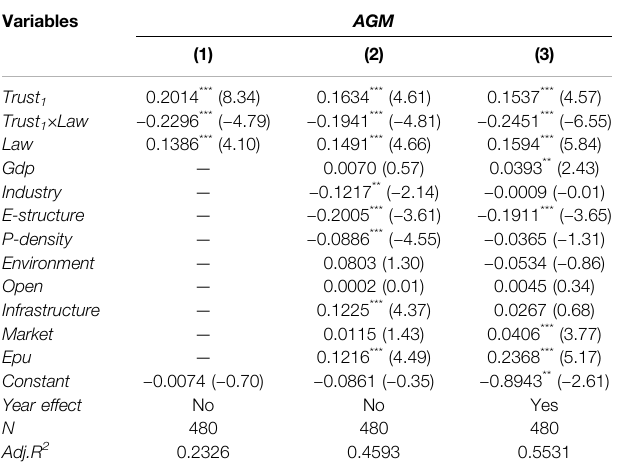
TABLE 5 | The moderating effect of legal